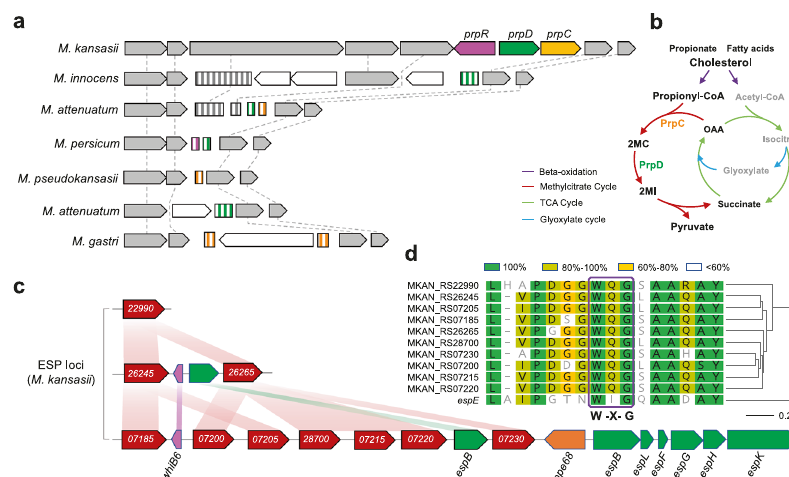
Fig. 4 Genomic loci speci fi c to M. kansasii . a Synteny map for the genomic region fl anking the genes of methylcitrate cycle (MCC) in M. kansasii . Full- length and truncated genes are represented by arrows and rectangles respectively. The full MCC genes in M. kansasii and their orthologous sequences in the other MKC species are indicated with different colors. The fl anking genes are in gray or white to represent homologous or orphan genes, respectively. b A scheme of the MCC of mycobacteria and its relation to the beta-oxidation, tricarboxylic acid (TCA) and glyoxylate cycles. 2MC 2-methylcitrate, 2MI 2-methylisocitrate, OAA oxaloacetate. c Synteny map of the three ESP (ESX-1 secretory protein) loci speci fi c to M. kansasii . Red arrows represent espE -like genes and the numbers indicate their MKAN_RS identi fi ers. d Sequence similarity between the EspE of M. tuberculosis and the EspE-like proteins of M. kansasii . Residues are colored to indicate